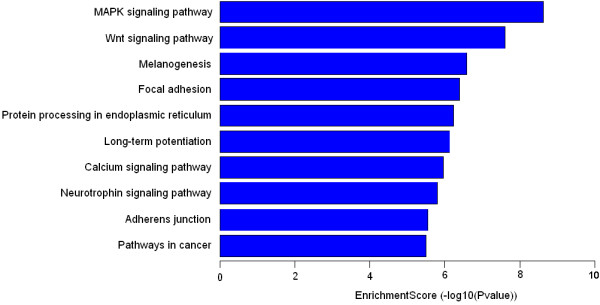
The significant pathway bar plot of designated gene. The bar plot shows the top ten Enrichment score (−log10(Pvalue)) value of the significant enrichment pathway